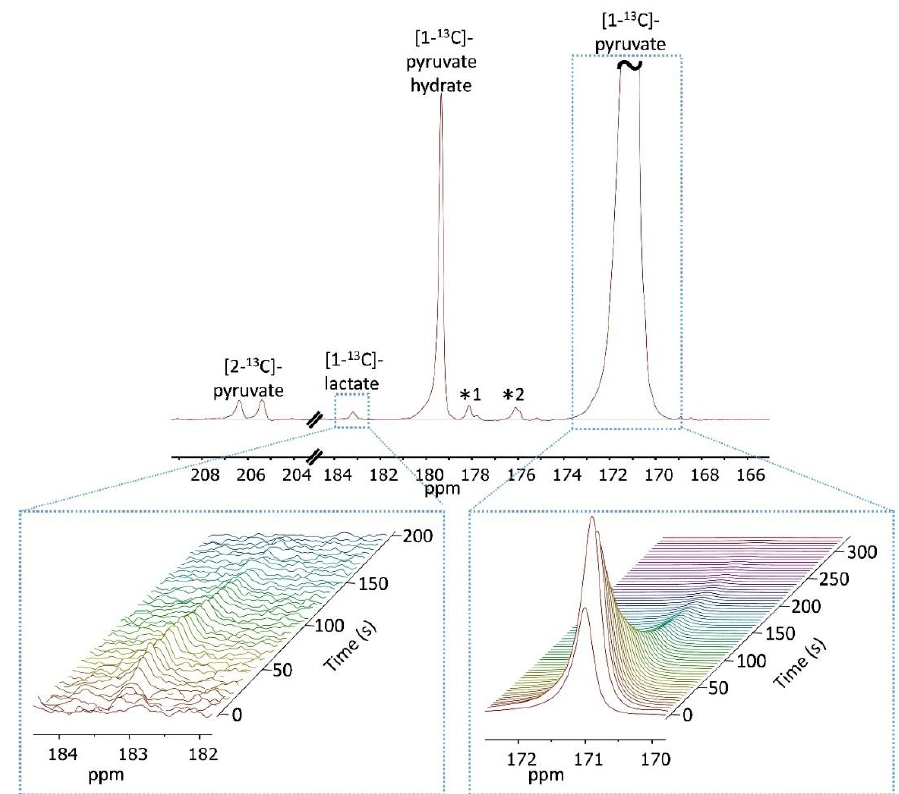
Figure 3. 13 C-NMR spectra of tumor slices in the presence of 14.4 mM hyperpolarized [1- 13 C]pyruvate. The upper panel presents a sum of 16 spectra acquired with a 12° nutation angle, a repetition time of 5 s, and 32,768 points. The spectra were processed with a 5 Hz exponential multiplication and zero filling of 65,536 points. The signal of [1- 13 C]pyruvate was truncated to allow dynamic range for visibility of the metabolite signal. The non-enriched C 2 position of [1- 13 C]pyruvate appears at 206 ppm. The asterisks (*1 and *2) represent impurities of [1- 13 C]pyruvate, most likely these are due to the C 5 and C 1 of zymonic acid (enol) respectively [56,59,60]. The bottom right panel shows the [1- 13 C]pyruvate signal over 330 s. In the first spectrum, the injection is still ongoing and from the 2 nd spectrum on, this signal shows only decay. The bottom left panel shows stacked spectra demonstrating a buildup and then a decay of the [1- 13 C]lactate signal over 205 s. The spectra were referenced to C 1 of pyruvate at 171.0 ppm.